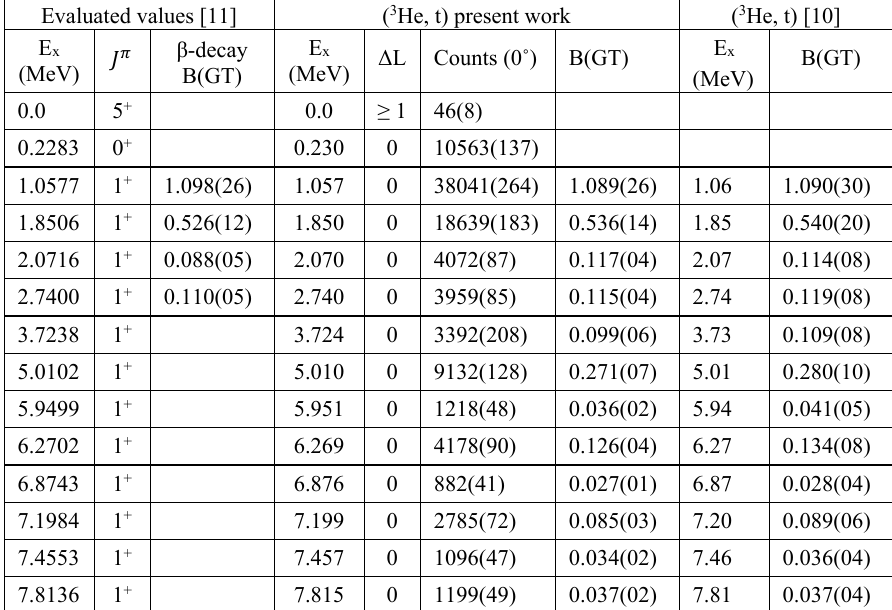
Table 1. States of 26 Al up to 8 MeV, GT transition strengths B(GT) and